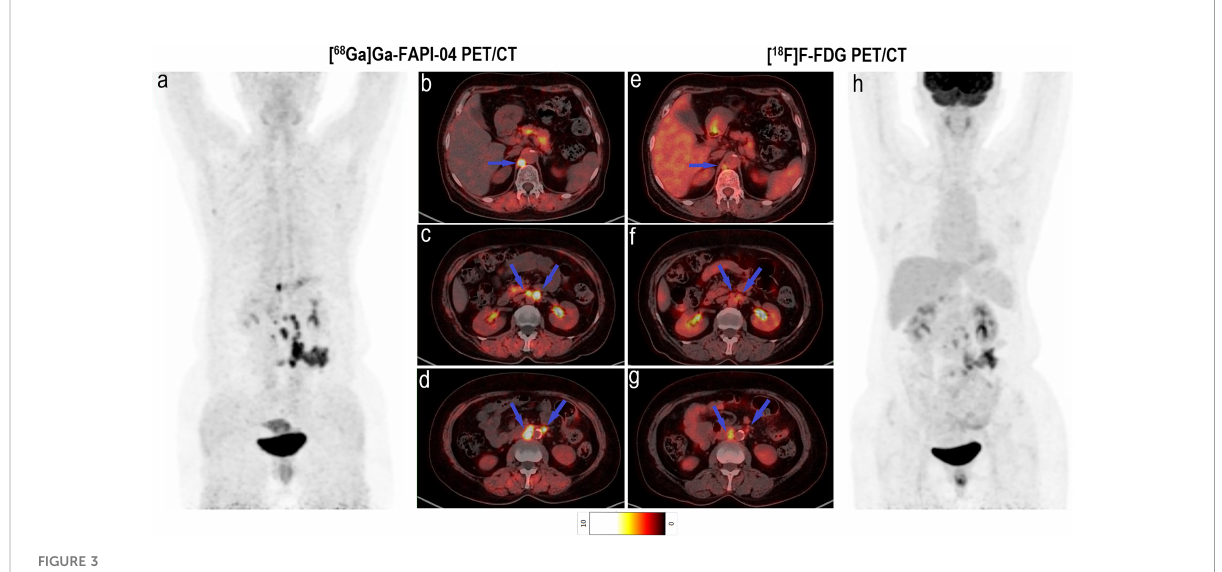
FIGURE 3 Images of a 64-year-old woman with colon cancer for staging. (A) Mean intensity projection images of [ 68 Ga]Ga-FAPI-04 PET/CT scans. (B – D) Axial fused images of suspicious lymph nodes at different levels of the body in [ 68 Ga]Ga-FAPI-04 PET/CT. (E – G) Axial fused images of suspicious lymph nodes at different levels of the body in [ 18 F]F-FDG PET/CT. (H) Mean intensity projection images of [ 18 F]F-FDG PET/CT scan. [ 68 Ga]Ga- FAPI-04 uptake (blue arrows in B – D ) was higher than [ 18 F]F-FDG uptake (blue arrows in E – G ) in both the diaphragmatic and retroperitoneal metastatic lymph nodes, with SUV max values of 5.9 – 12.0 and 3.4 – 4.3,